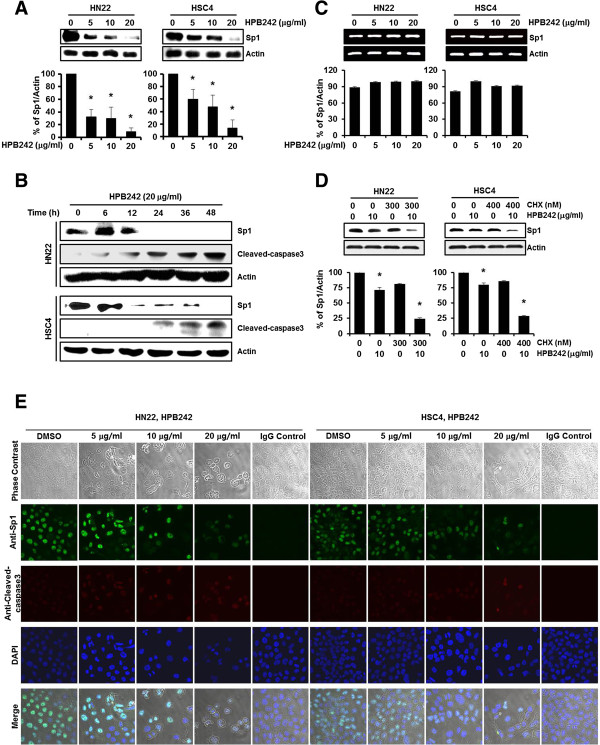
The effect of HPB242 on specificity protein 1 (Sp1) protein expression in HN22 and HSC4 cells. HN22 and HSC4 cells were incubated with different concentrations of HPB242 for 48 hours. The cells were harvested and prepared for western blots as described under Methods. Protein expression levels of Sp1 were detected using a specific antibody against Sp1, and its levels were quantified after actin normalization. (A) The HPB242-treated cells were compared with untreated cells, and data are shown as the means ± SD of three independent experiments. The asterisk indicates a significant difference compared with the negative control (untreated cells) (*p < 0.05). (B) Time-dependent effects of HPB242 on Sp1 and Cleaved-caspase3 expression were performed in HN22 and HSC4 cells for 48 hours with 6 hours intervals. (C) The effect of HPB242 (0–20 μg/ml) for 48 hours on Sp1 mRNA expression was determined by RT-PCR. The graphs indicate the ratio of Sp1 to β-actin expression. (D) The effect of HPB242 on Sp1 protein turnover in HN22 and HSC4 cells. The protein lysates were obtained from cells pretreated with protein synthesis inhibitor such as cycloheximide (CHX) for 2 hour and then exposed to HPB242 for 48 hours. The protein expression of Sp1 was analyzed by western blot analysis. (E) Immunocytochemistry analysis was performed in HPB242 treated HN22 and HSC4 cells. HN22 and HSC4 cells were treated with different concentrations of HPB242 for 48 hours, and cells were immunostained with Sp1 specific antibody, Cleaved-caspase3 specific antibody, and then signals were detected with Jackson 488- and 647-conjugated anti-mouse secondary antibody. DAPI was used for nucleus staining. 254×190 mm (96 × 96 DPI).